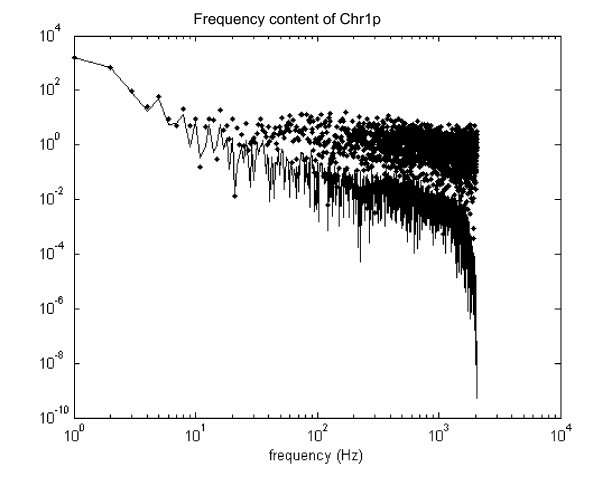
Comparison with Fourier Power Spectrum. Power spectrum of the raw pattern extracted by SVD for Chr1p (see Fig. 5B) (dotted) and that of the de-noised spectrum (see Fig. 5D) (line). Note that the de-noising procedure effectively removes the noise at high frequencies but preserves the large structure in the signal (< 10 Hz). The dip in the de-noised spectrum at > 103 Hz is due to the zeroing of the highest frequency content in the WT corresponding to the single probes expression.